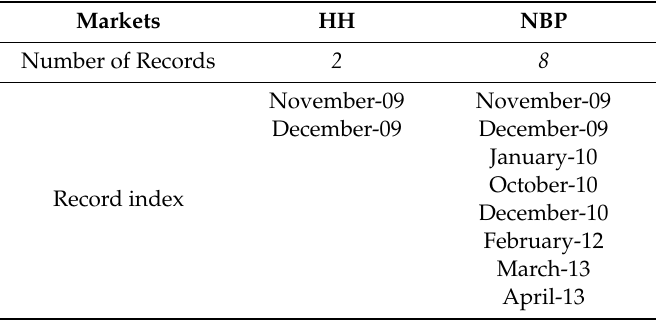
Table 5. Number of records and record index.